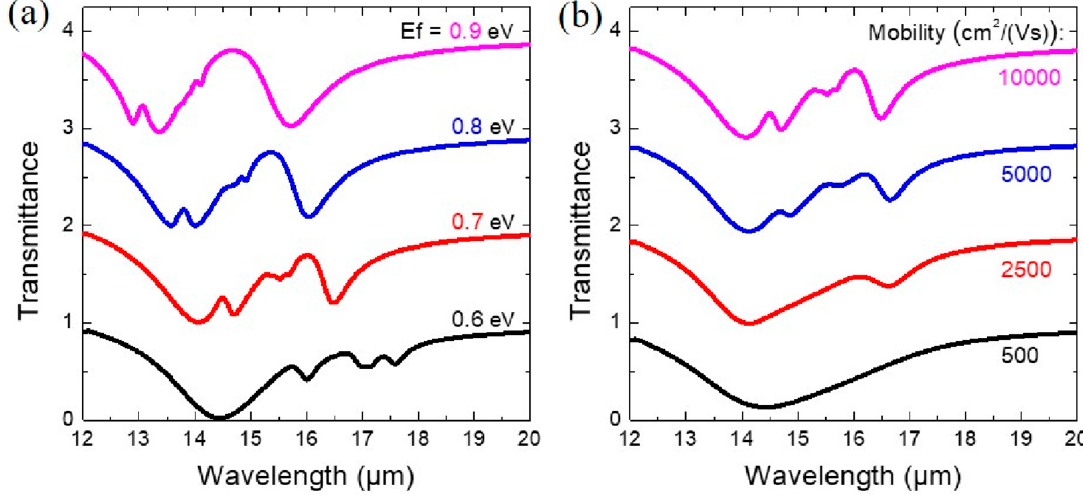
Figure 5. Transmittance of the hybrid structure with various ( a ) Fermi energies and ( b ) mobilities of the